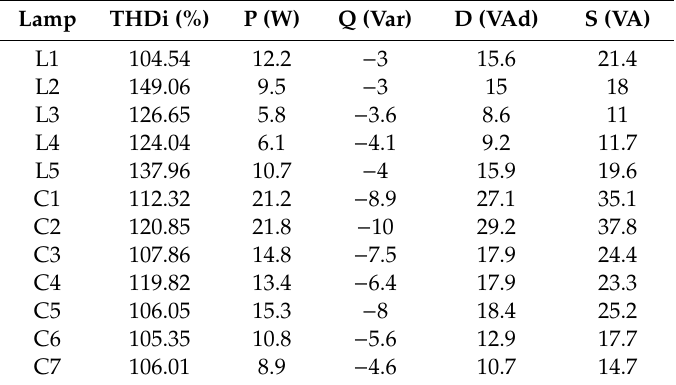
Figure 1. Measurements obtained for individual lamps: Harmonic spectrum ( a ), waveform ( b ) and phasor diagram ( c ) of the L3 lamp. Harmonic spectrum ( d ), waveform ( e ) and phasor diagram ( f ) of the C7 lamp. Table 3. Values measured with the Fluke analyzer on the twelve